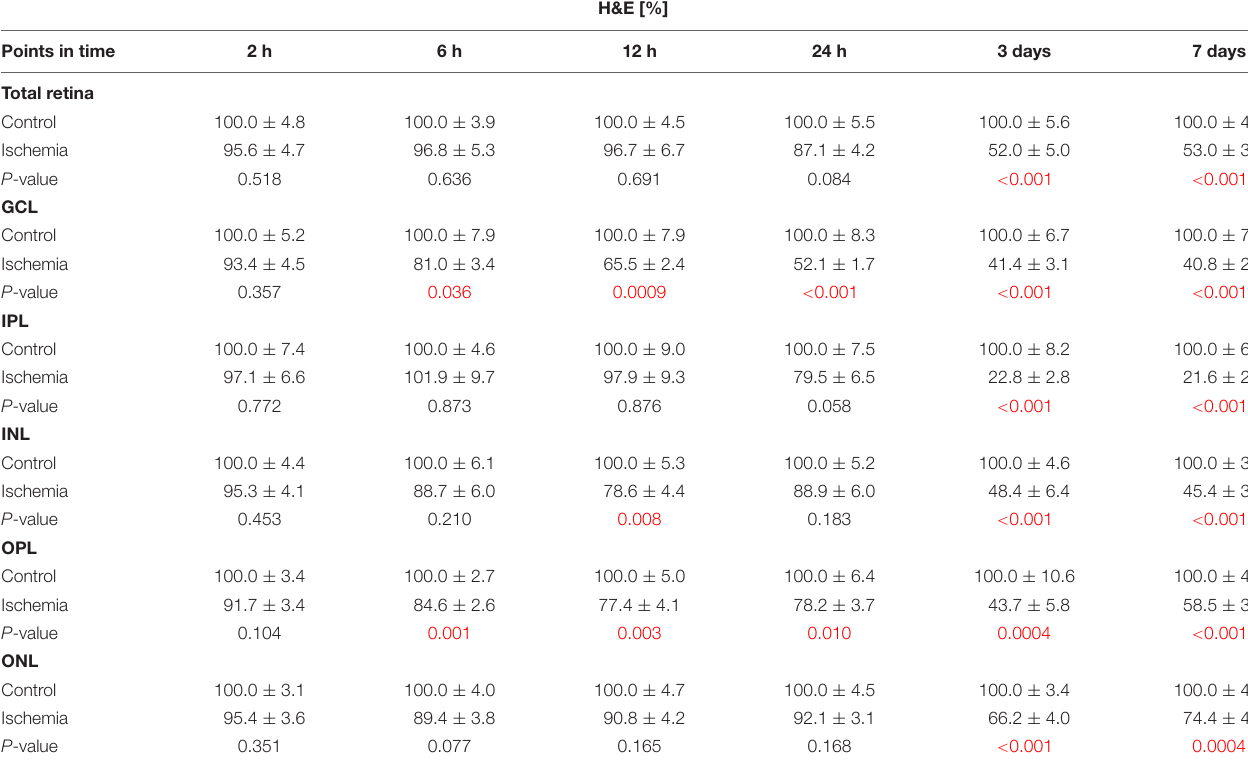
TABLE 4 | Analyses of the layer thicknesses (%) of the H&E stained cross-sections at all points in